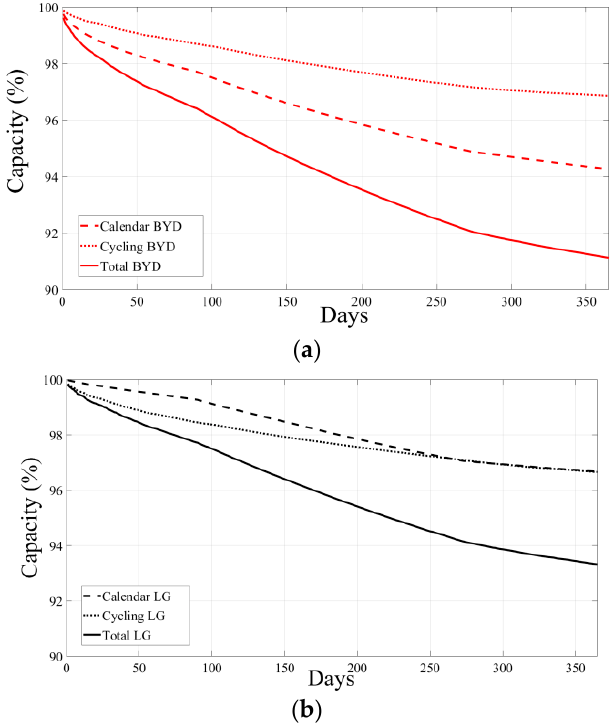
Figure 7. Cycling, calendar, and total capacity reduction in one year for a 3.3 kWh LiFePO 4 (LFP) ( a ) and LiNiMn ‐ CoO 2 (NMC) ( b ) battery operated at location A within household 1.